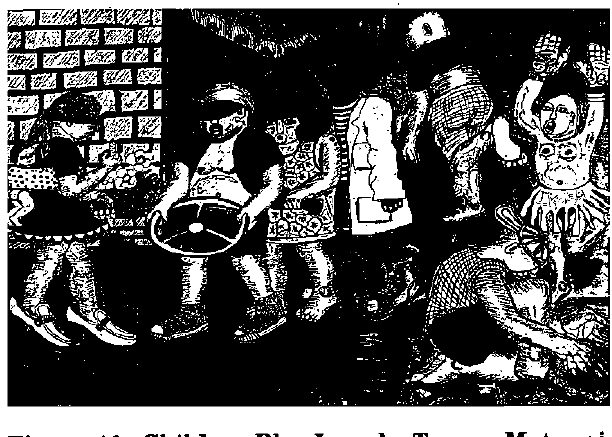
Figure 10: Children Play Love by Tommy Motswai (Reprinted from: Standard Bank Young Artist Award 1992. Photography: Michael